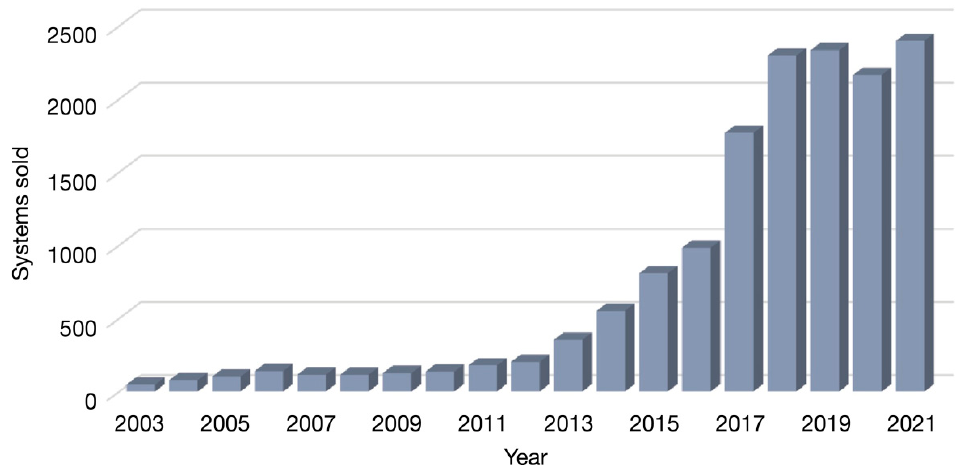
Figure 1. Metal Additive Manufacturing systems sold from 2003 to 2021 (adapted from [4]). Table 1. Metal AM systems and their building volumes [18].